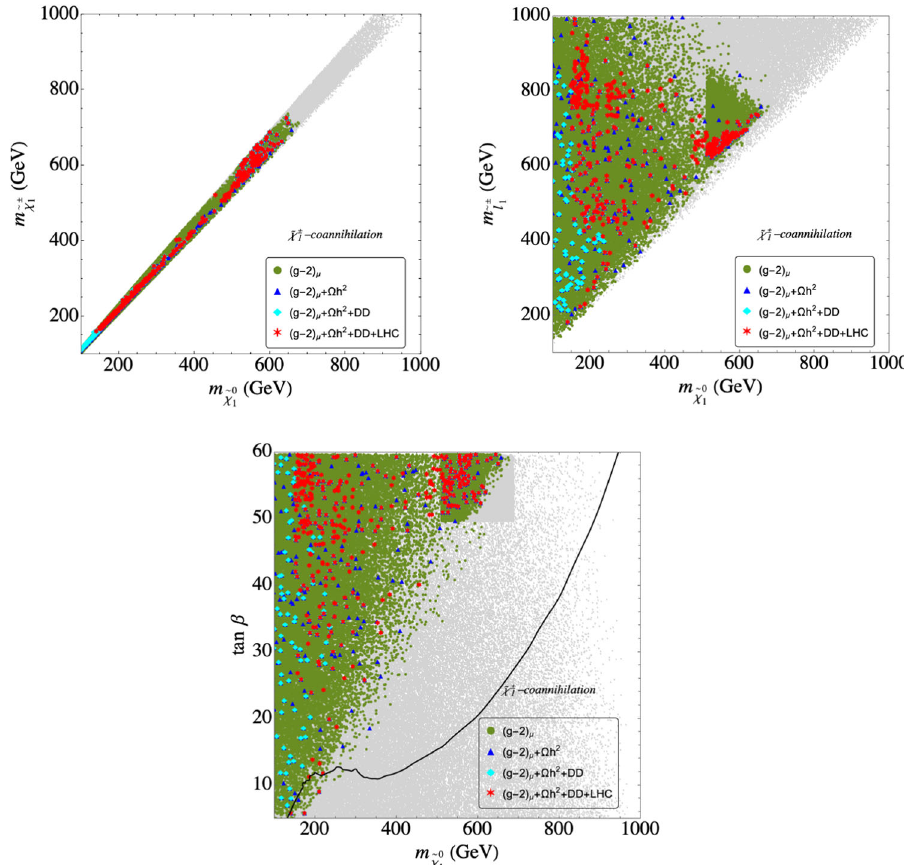
Fig. 1 Results in the ˜ χ ± -coannihilation scenario: 1 m ˜ χ 0 – m ˜ χ ± plane (upper left), 1 1 m ˜ χ 0 – m ˜ plane (upper right), l 1 1 m ˜ χ 0 –tan β plane (lower 1